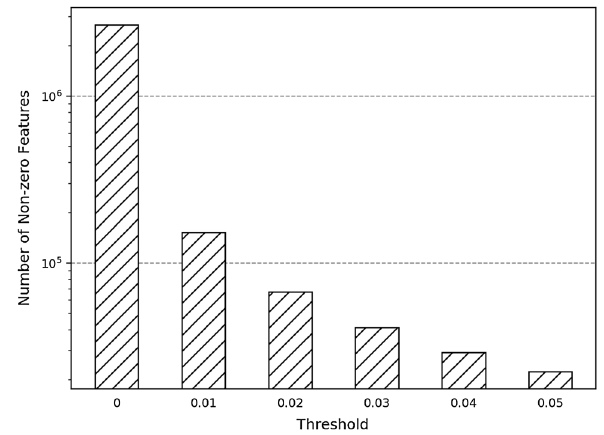
Fig. 1 Number of nonzero features generated with various job title ratio score thresholds 4